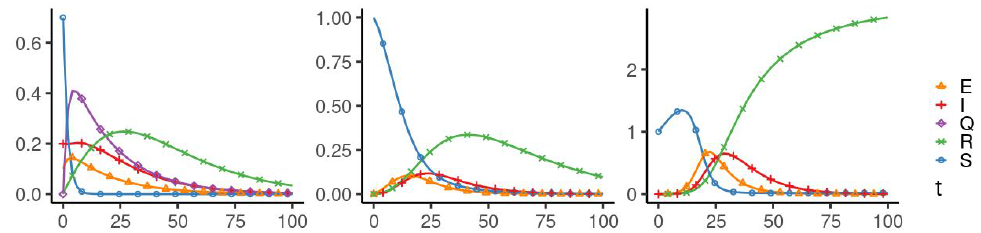
Figure 11. Experiment 2. Spread of the virus in three different clusters in the uncontrolled